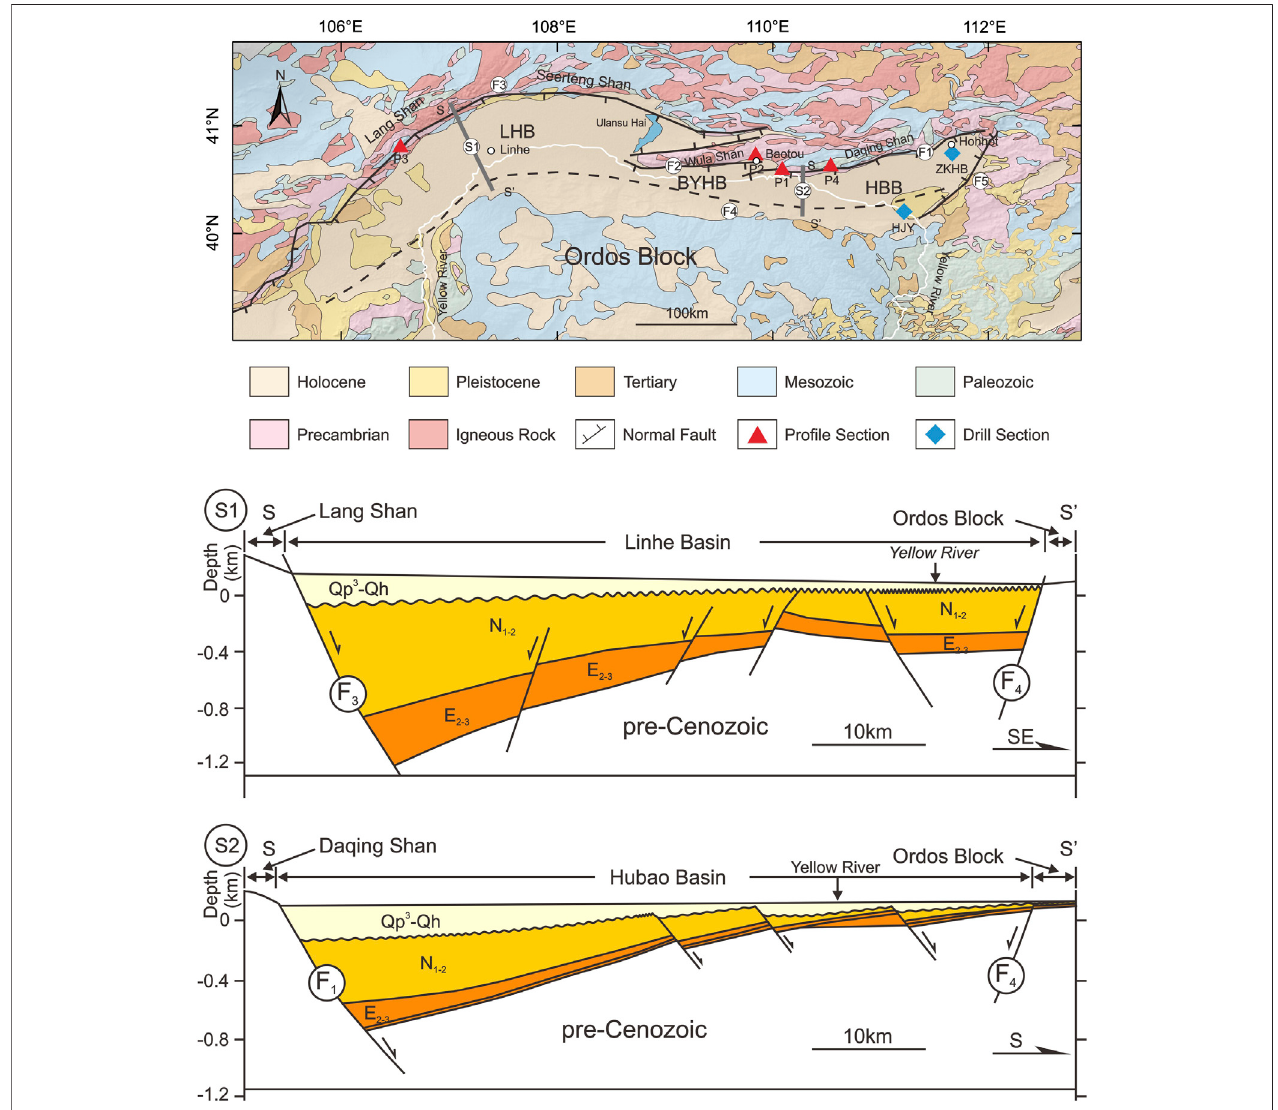
FIGURE 2 | Simpli fi ed geological map and Active faults distribution around the Hetao Basin (The Research Group on Active Fault System around Ordos Massif, State Seismological Bureau (RGAFSO), 1988). Structural section S1 and S2 modeled after Shi et al., 2020.